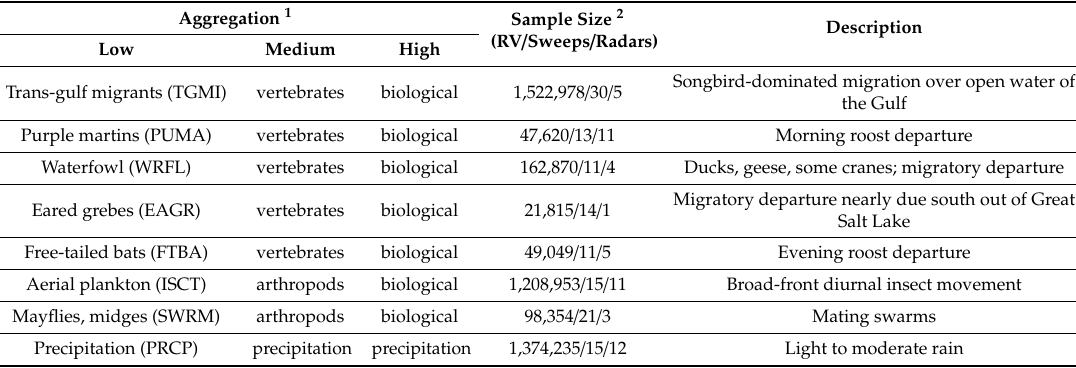
Table 1. Scatterer types included in classification training data.